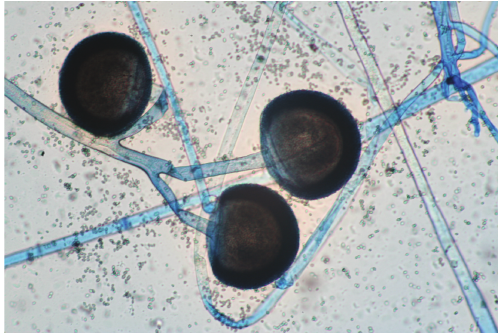
Figure 3: Sporangiophores with big sporangia, with no apophysis, rhizoids or stolones, compatible with Mucor sp .